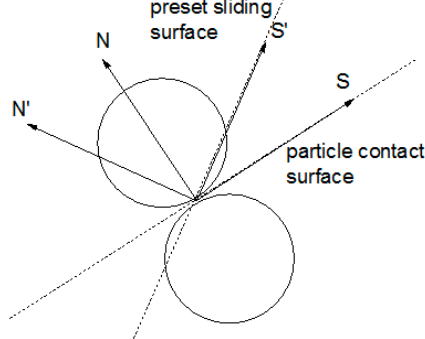
Figure 7. The direction of preset sliding surface and particle contact surface.